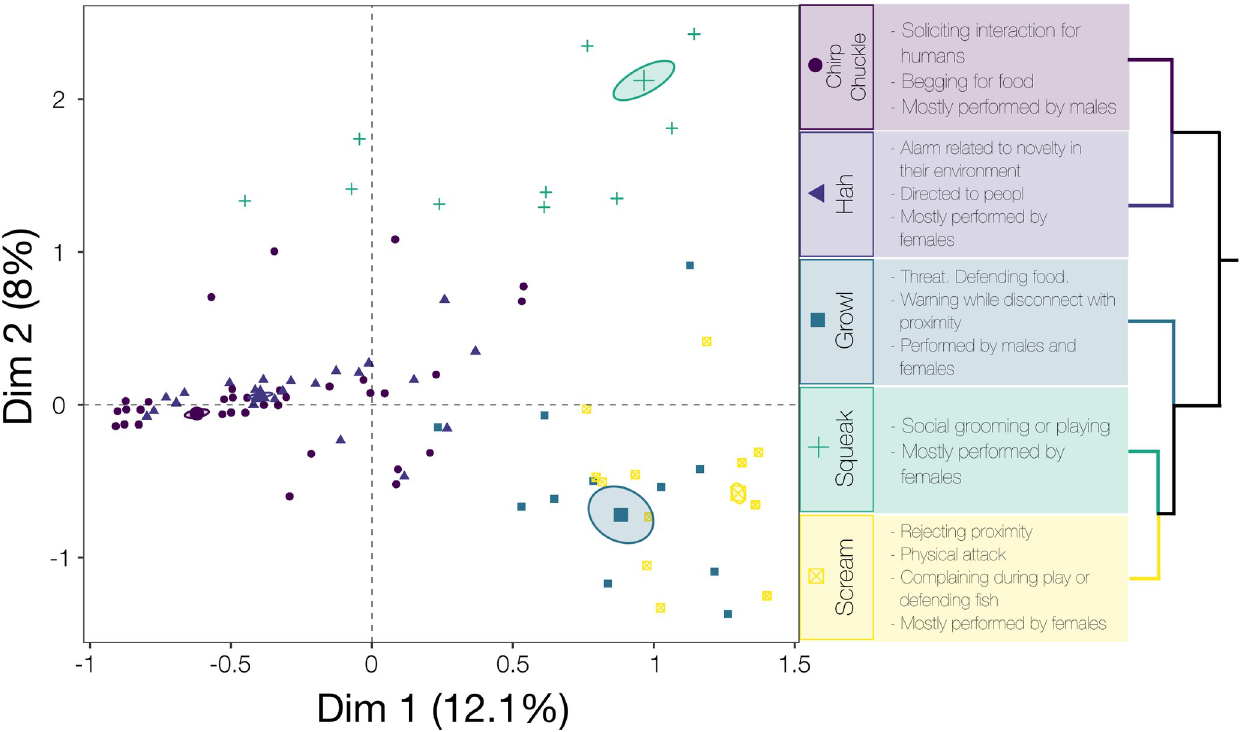
Fig 2. Biplot of multiple correspondence analysis with hierarchical clustering summarizing the association between call types, behavioral contexts and sexes. Larger symbols represent centroids, and ellipses represent 95% confidence intervals.